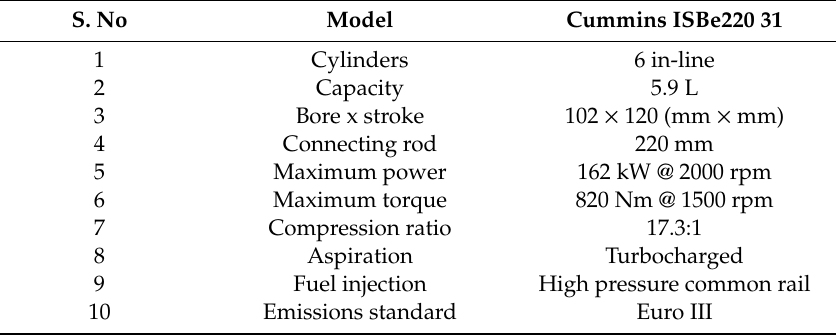
Table 1. Specifications of the engine used in the current study